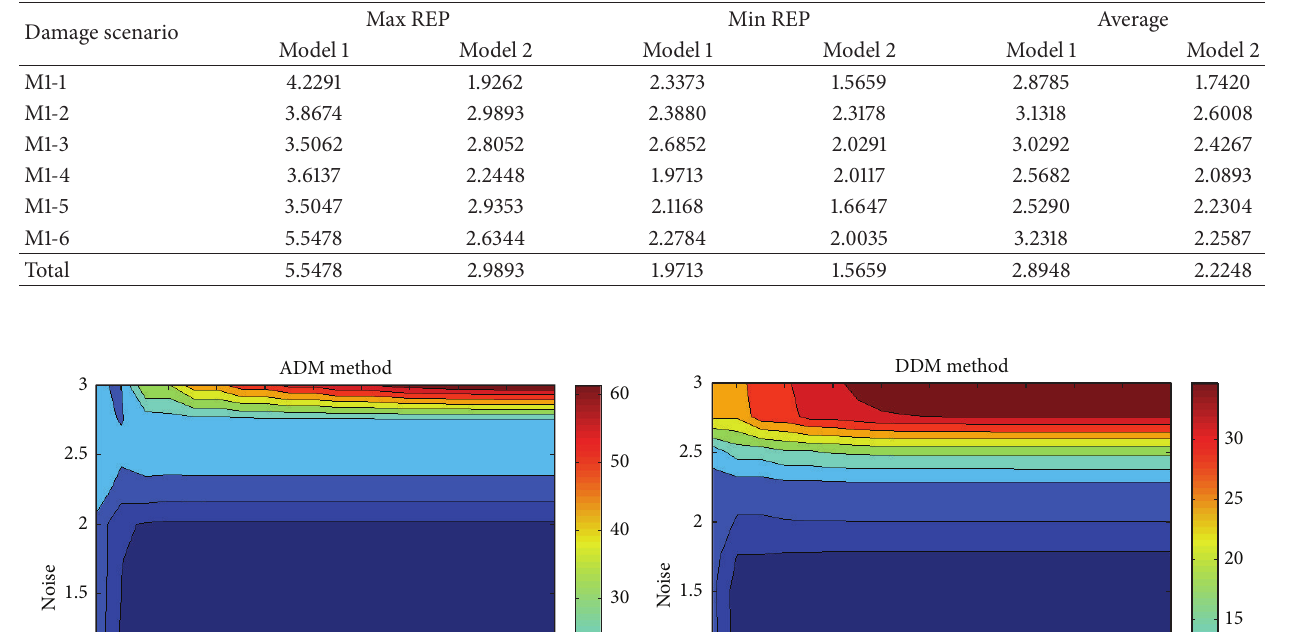
Table 10: REP ranges in different scenarios. adj,ddm